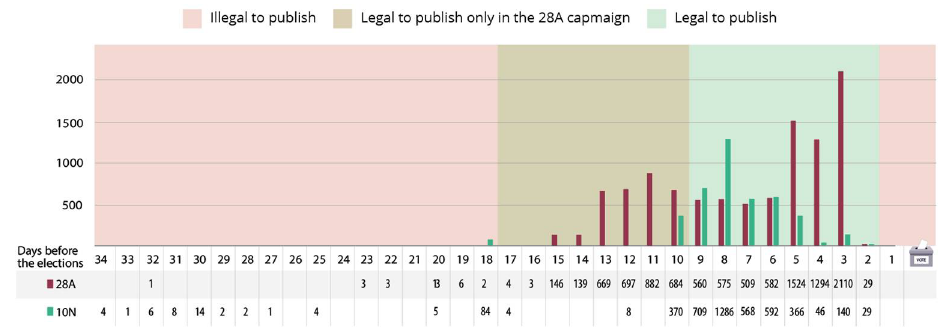
Figure 1. Ads published during the studied periods. Source: Own elaboration.